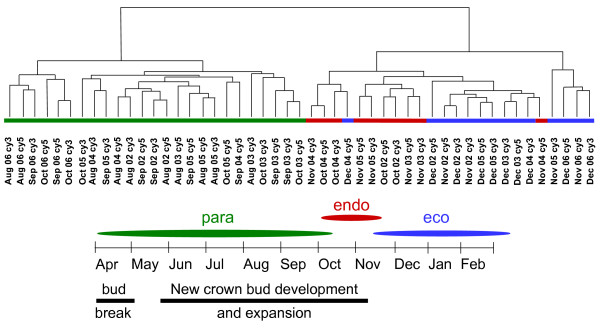
Cluster analysis of expression data. Green lines indicate samples designated as paradormant, red lines indicate samples designated as endodormant, and blue lines indicate samples designated as ecodormant. Monthly representation of bud development growth and dormancy transitions is shown below.